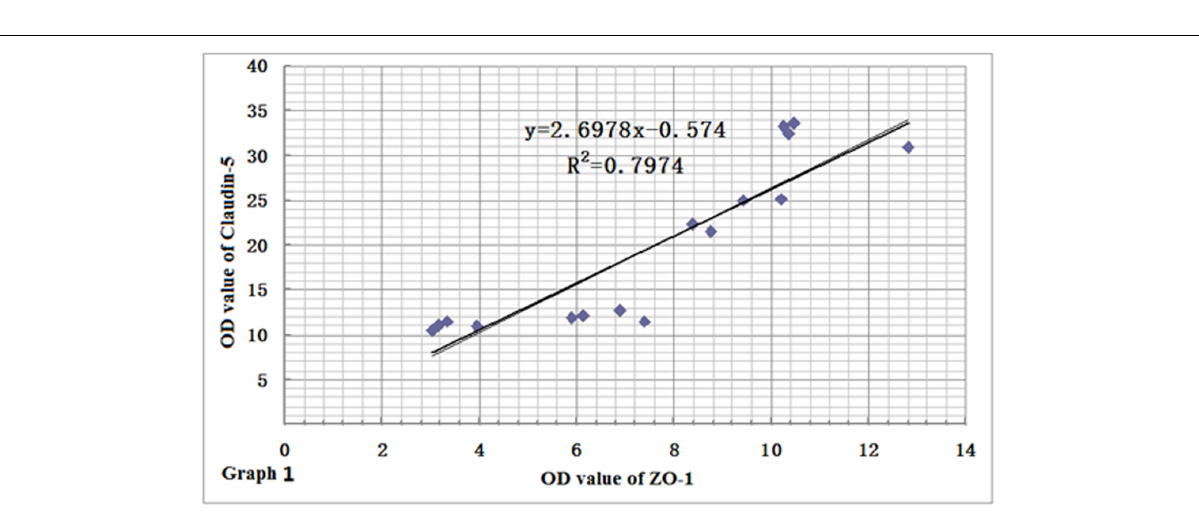
FIGURE 9 | Relationship between ZO-1 and claudin-5 protein expressions. The variation of ZO-1 protein level was similar to that of claudin-5, and there existed positive correlation between the two proteins ( r = 0.8930, n = 4).